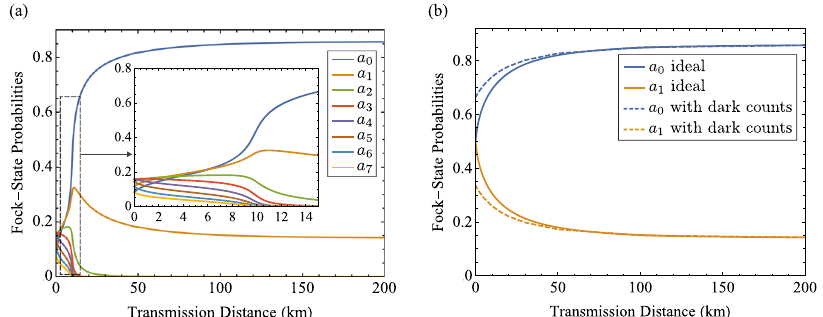
Fig. 3 Simulation results of the optimised coef fi cients. a The optimised coef fi cients of the states shown in Eq. (2) and (3) with n max ¼ 7 photons, where the coef fi cients are explicitly shown in Table 2. b The optimised coef fi cients of the states shown in Eq. (2) and (3) with n max ¼ 1 photon (refer to Table 3 for the optimised coef fi cients for each distance).